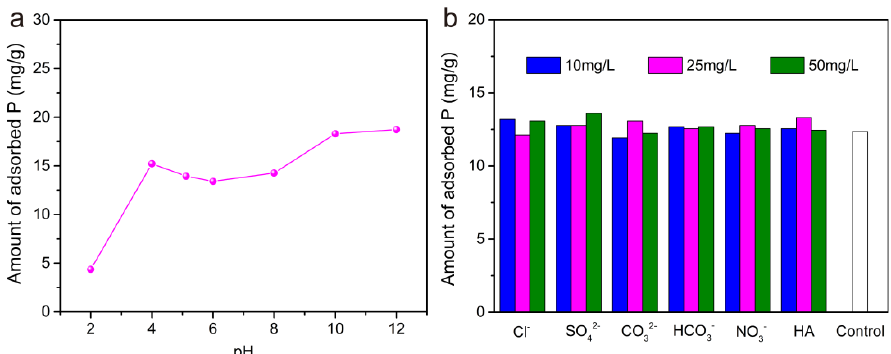
Figure 7. Effects of ( a )different solution pH values and ( b ) interfering ions on phosphateadsorption by MALS-B.